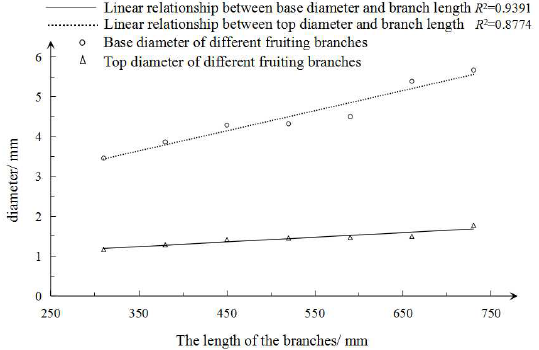
Figure 6. Relationship between branch base circle diameter and branch length.